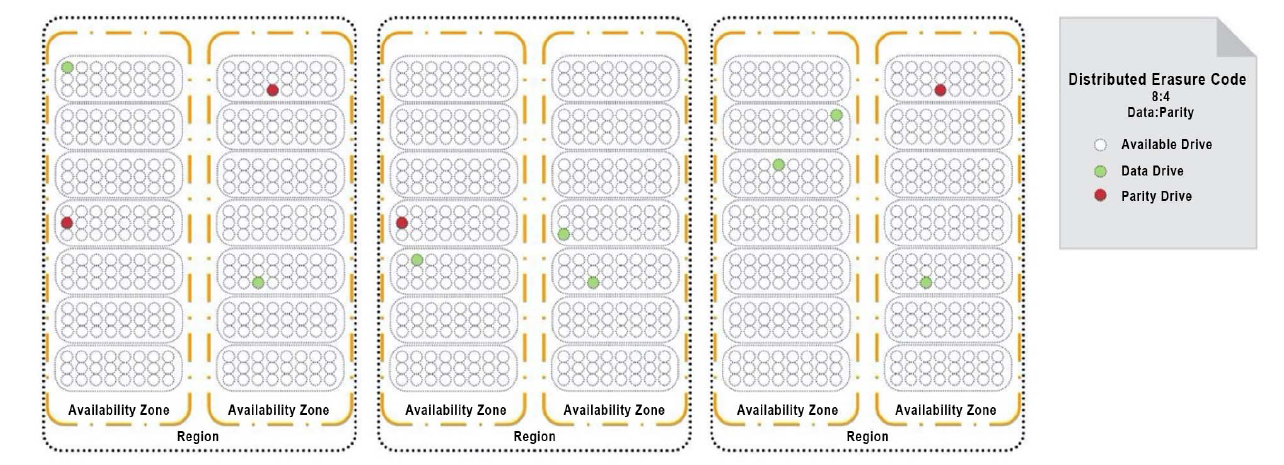
Figure 8. Distributed Erasure